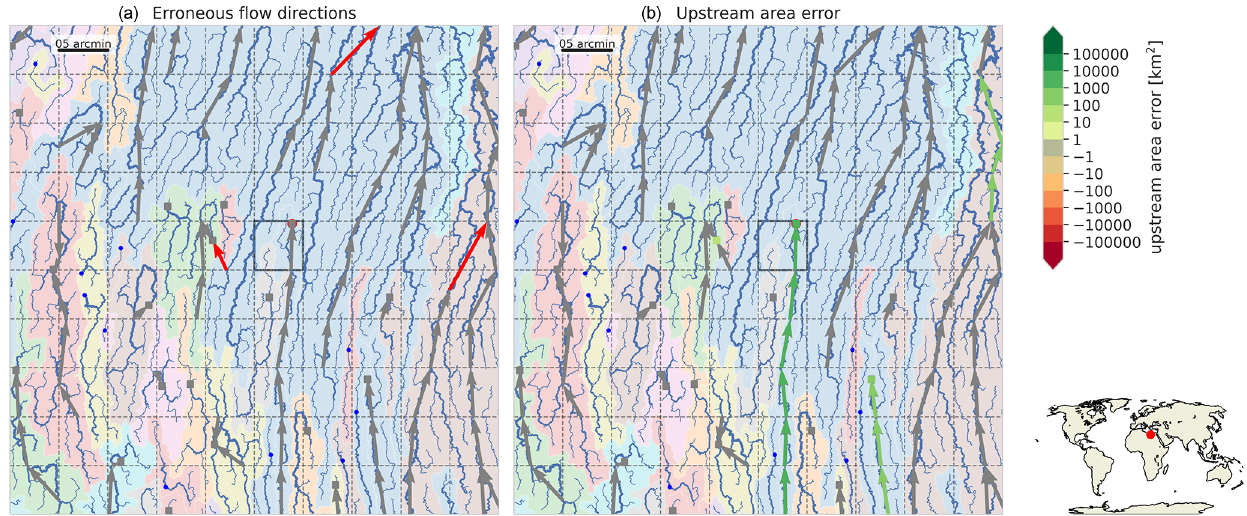
Figure C4. Largest basin (16717km 2 ) with a relative upstream area error of more than 10% at the 5arcmin resolution indicated with a highlighted cell. See the caption of Fig. C1 for a full